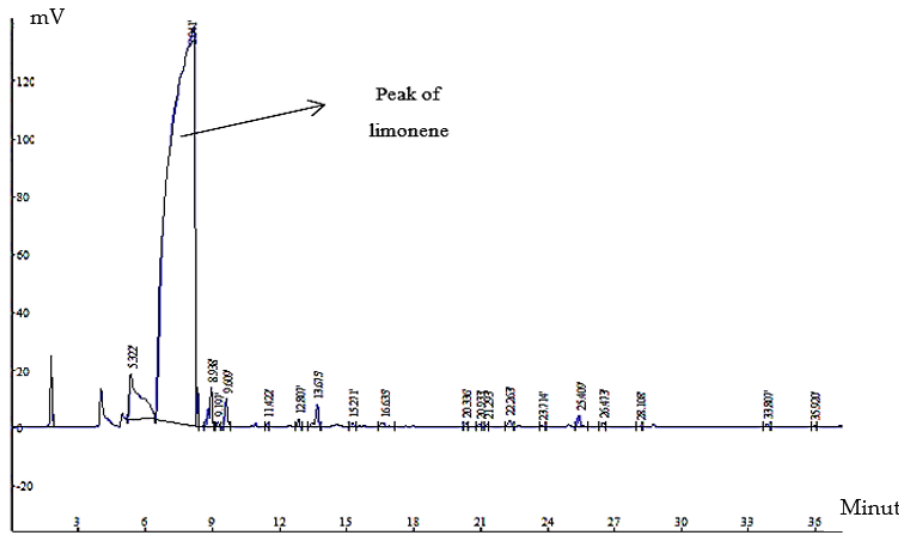
Figure 2. Chromatogram related to gas chromatography of OPO.